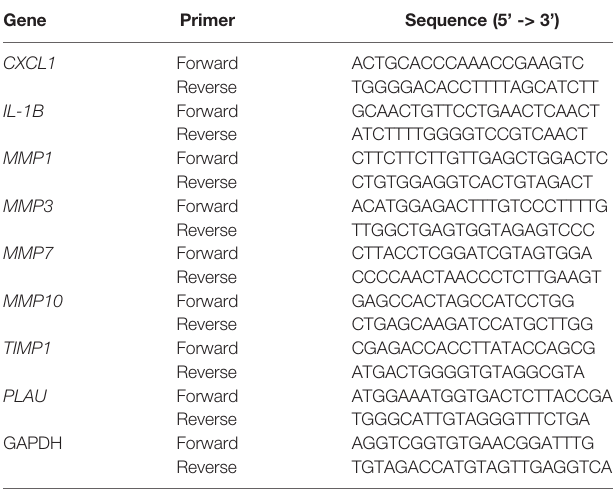
TABLE 2 | Primers for